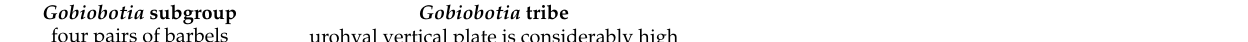
Pseudogobio subgroup one pair of barbels or be